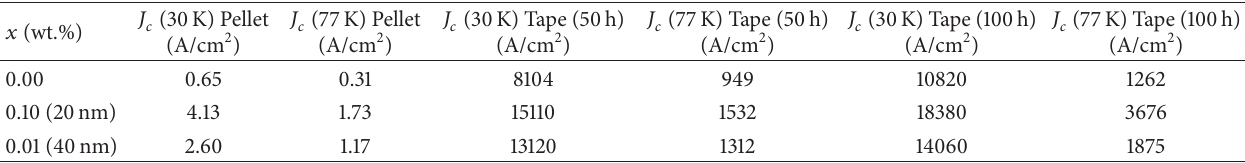
Table 1: 𝐽 𝑐 (at 0T) of 𝑥 = 0 wt.%, 𝑥 = 0.10 wt.% of 20nmMgO, and 𝑥 = 0.01 wt.% of 40 nmMgO added pellets and tapes sintered for 50h and 100h at 30 and 77